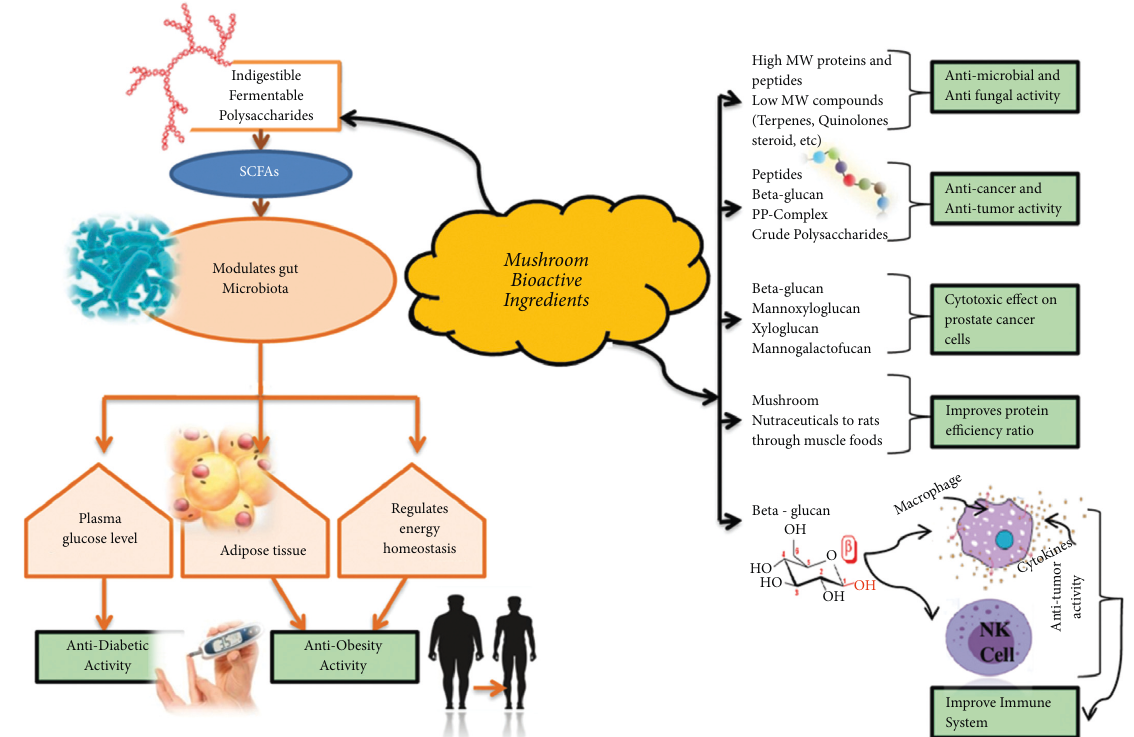
Figure 3: Schematic flowchart depicting the health-promoting and medicinal characteristics of mushroom bioactive ingredients (NK � cell- natural killer cell; SCFA � short-chain fatty acids; MW � molecular weight; PP-complex � protein-polysaccharide